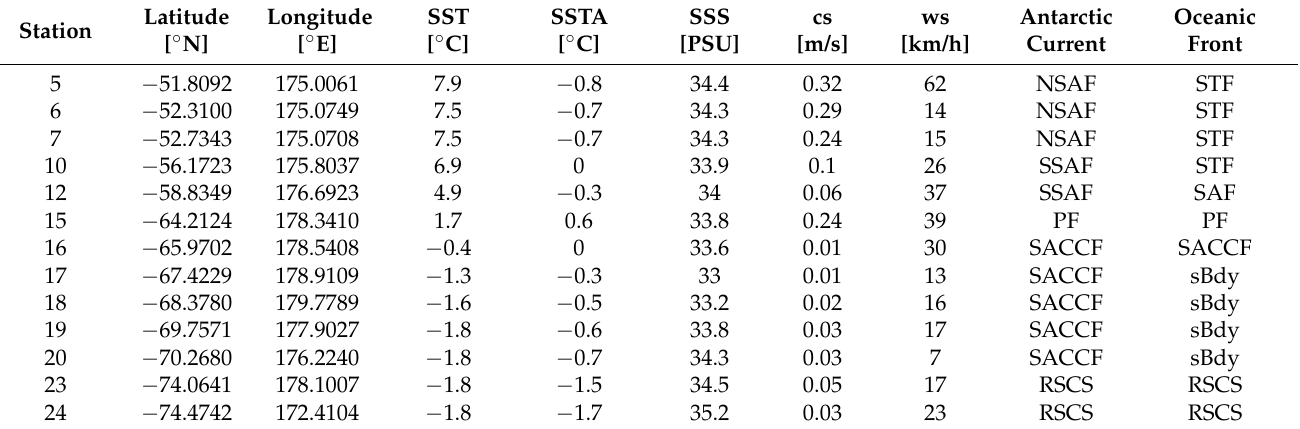
Table 1. Coordinates and environmental parameters of sequenced stations. SST—Sea Surface Temperature; SSTA—Sea Surface Temperature Anomaly; SSS—Sea Surface Salinity; CS—Current